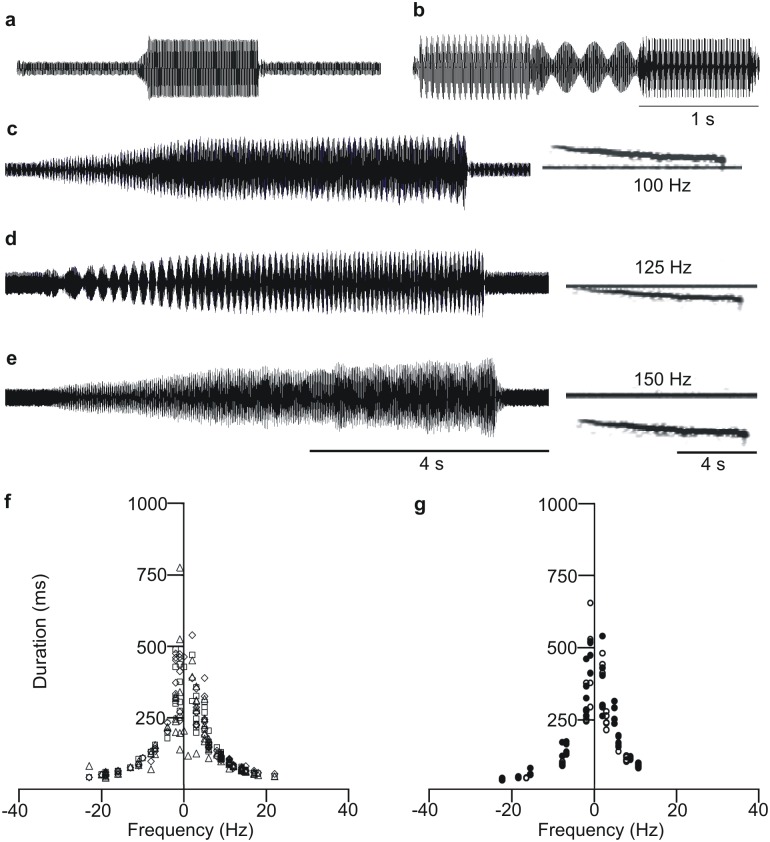
Interference induced on a soybean plant by overlapping pure tones and playback MS-1 signals.Oscillograms of a continuous 150 Hz/1.26 mm/s vibration masking (a) a 150 Hz/5.29 mm/s pulse and (b) fused 125 Hz/3.85 mm/s (left), 150 Hz/2.69 mm/s (middle) and 200 Hz/3.49 mm/s (right) pulses. Oscillograms (left) and sonograms (right) of MS-1 (dominant frequency = 111 Hz, velocity = 7.46 mm/s) playback overlapped by (c) 100 Hz/1.47 mm/s, (d) 125 Hz/1.48 mm/s and (e) 150 Hz/1.88 mm/s continuous vibration. f: mean (N = 2–24) pulse duration of MS-1 signals (n = 12) (SD<40% of the mean) masked by 125 Hz/1.16 mm/s pure tone and recorded on soybean (diamonds), C. cayan (squares) and bean (triangles); pulse duration was determined in 12 play-back signals in 1000 ms sections starting from the beginning to the end of the MS-1 signal. g: mean (N = 2–24) pulse duration of two artificially induced MS-1 signals (SD<40%) masked by 125 Hz pure tone of different velocities and determined in 1000 ms sections, starting from beginning to of the MS-1 signals recorded on soybean.